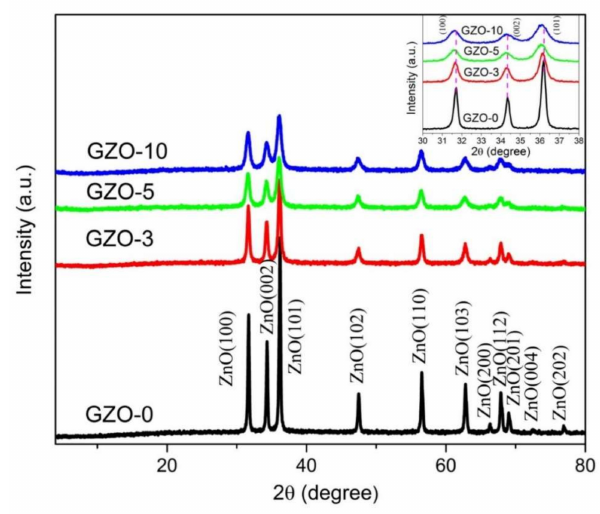
Figure 2. XRD patterns of as-synthesized Ga doped ZnO (GZO-0, GZO-3, GZO-5, and GZO-10)